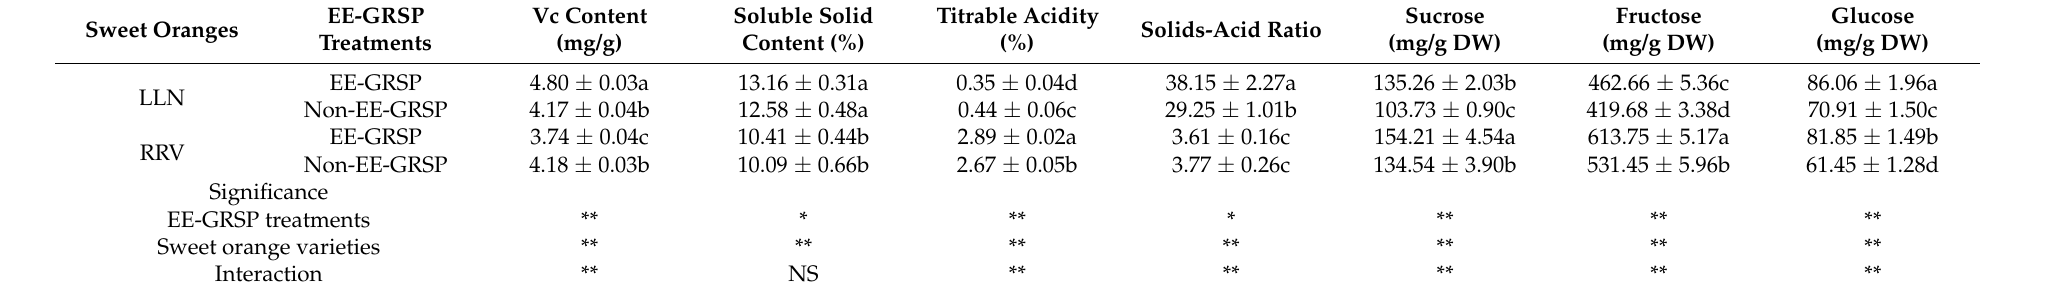
Table 3. Application response of exogenous EE-GRSP on the internal fruit quality parameters of late ripening sweet oranges.